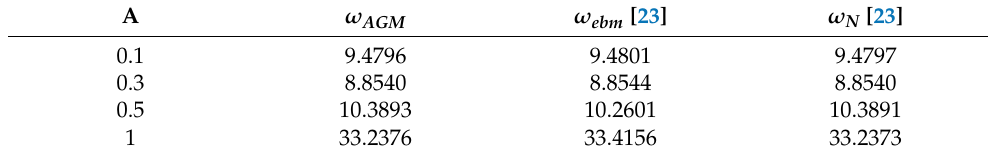
Table 6. Comparison between AGM, EBM and exact numerical solution for S-S beam (case study 3).